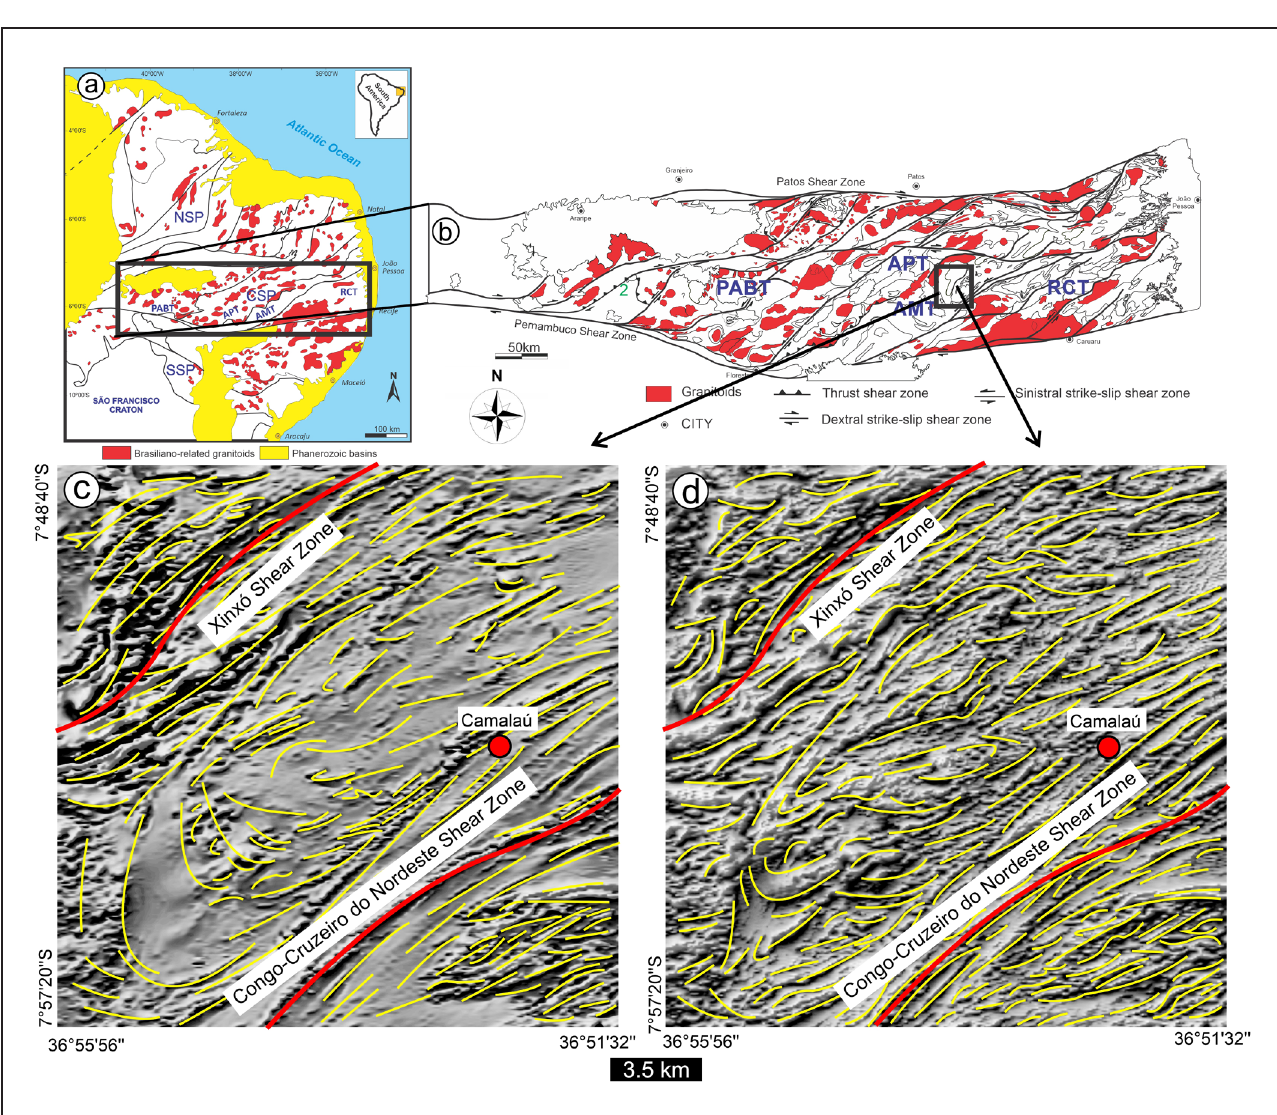
FIGURE 1 - Localization of the Central Subprovince in the context of the Neoproterozoic Borborema Province; b) The studied area within the Central Subprovince terrane map; c) The first derivative magnetic map of the studied area; d) Tilt derivative map of the studied area. Yellow lines mark the interpreted magnetic lineaments, whereas red lines mark the strike-slip shear zones, the main